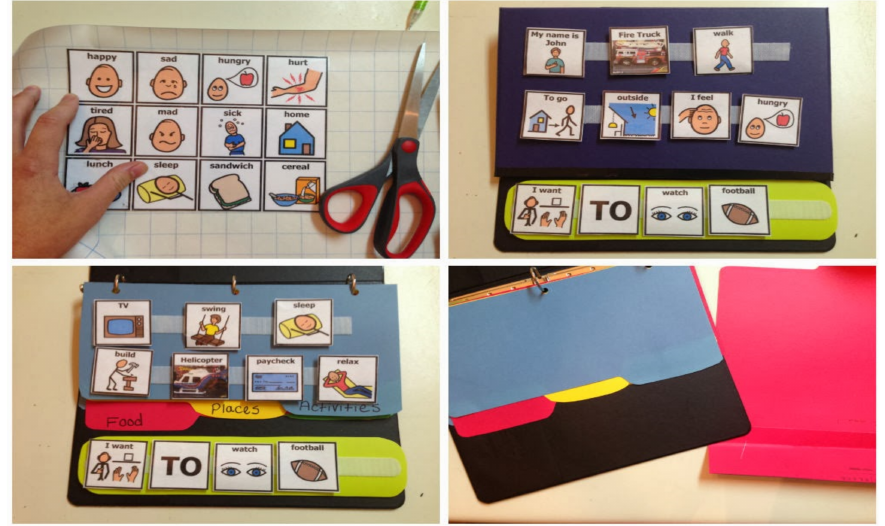
Figure 2. Materials for creating a PECS system.